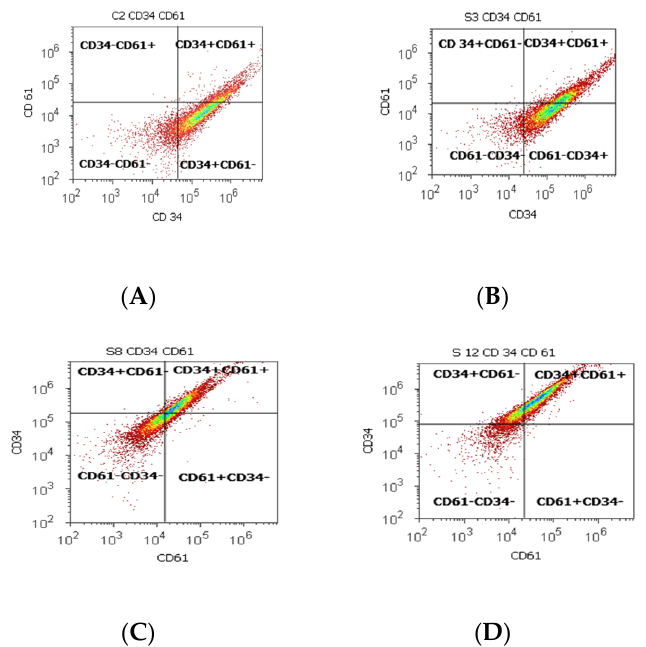
Figure 2. Cell proliferation highlights the double-positive populations of glycoprotein expression (CD34+ CD61+) with CD34- Alexa Fluor 488 and CD 61-PE dual stain. Cell adhesion is interpreted by the CD34 + CD61+ population: ( A ) 17.98%; ( B ) 33.63%; ( C ) 45.71%; ( D ) 59.68%. Legend: ( A ) non-malignant prostate tissue adjacent to nodular hyperplastic tissue; ( B ) adenoleiomyoma prostate tissue, chronic inflammation hyperplasia; ( C ) malignant prostate tumor tissue; ( D ) benign prostatic tissue hyperplasia. CD 61+ cell population, characteristically for platelets and T cell aggregation to tumoral cells and endothelium, presented significantly increased levels of PCa (37.81 ±